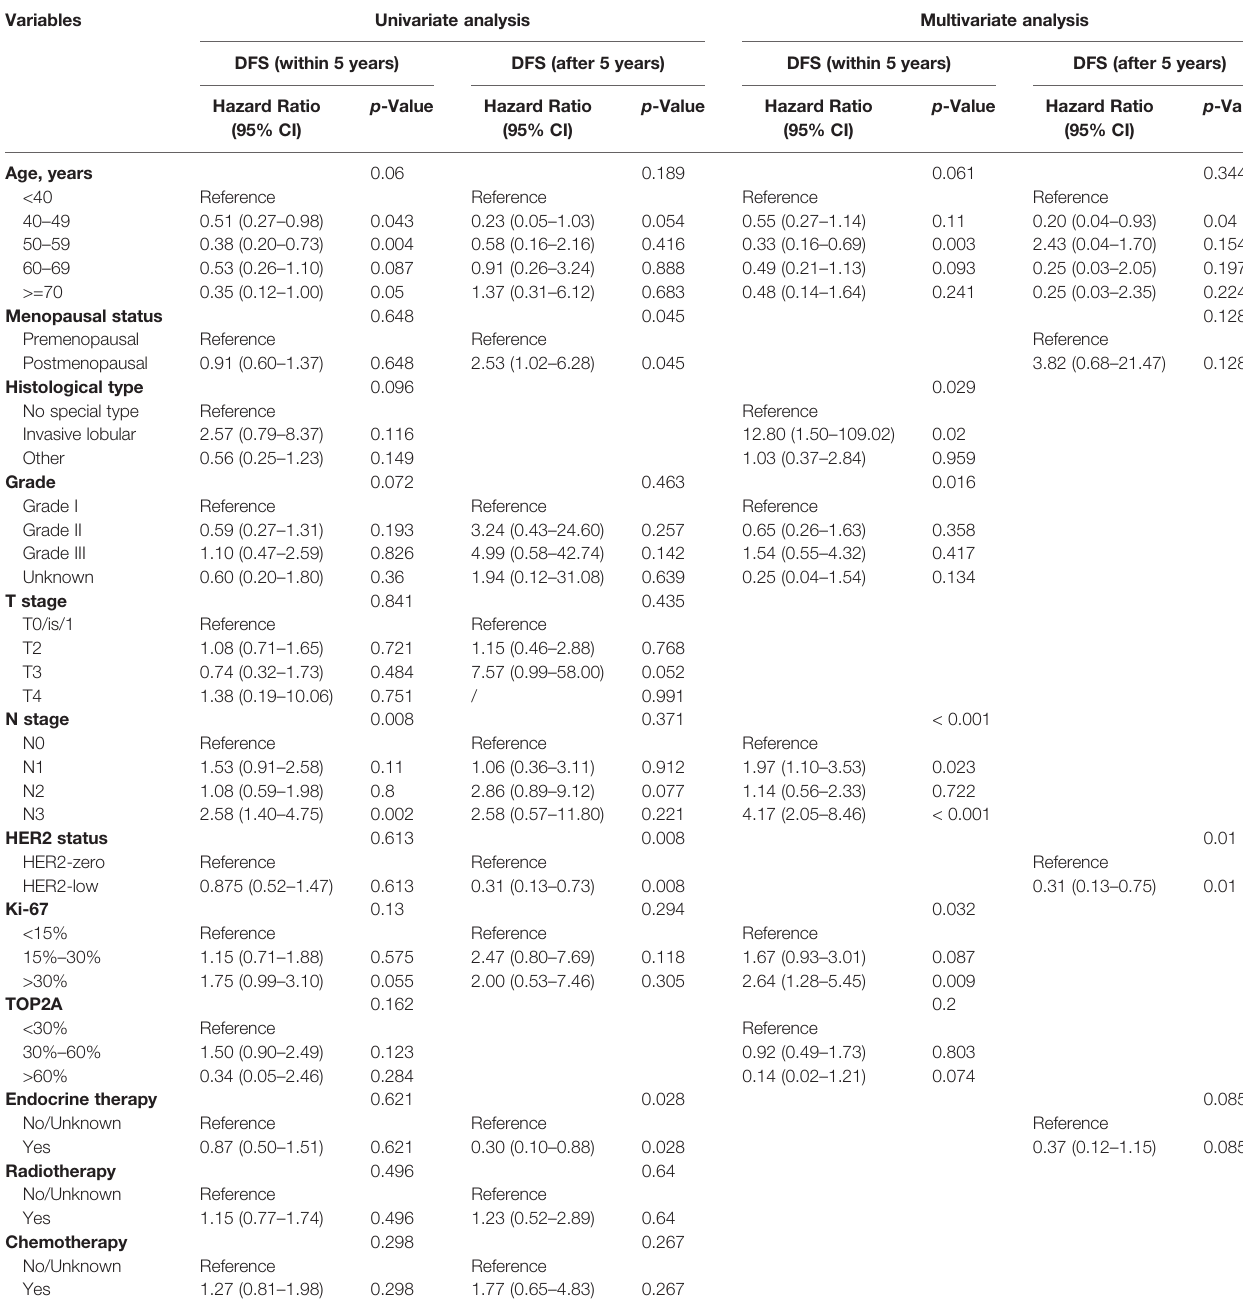
TABLE 2 | Univariate and multivariate analysis of variables correlated with DFS in HR-positive patients within and after 5 years.